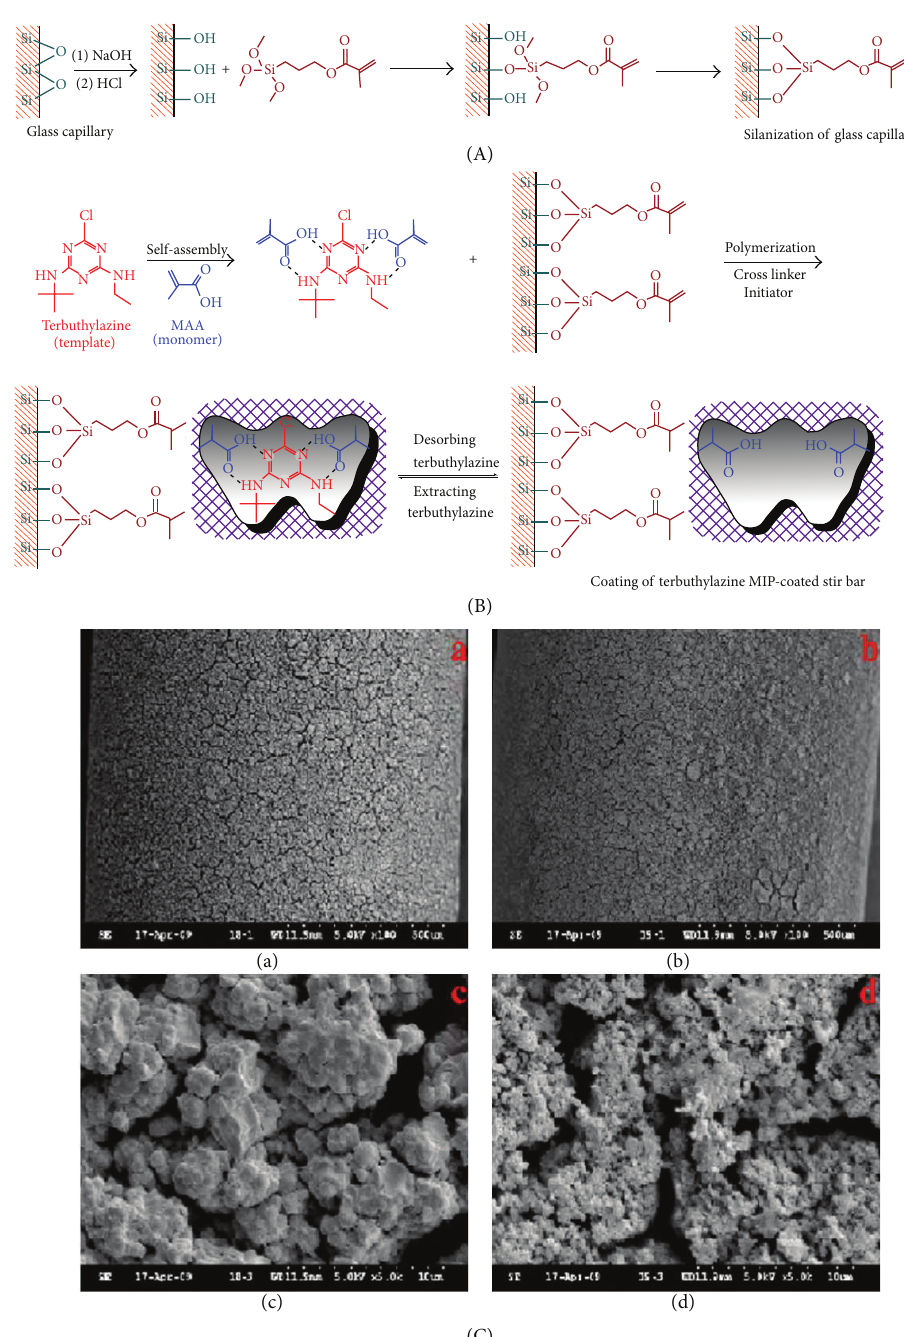
Figure 11: Schematic diagrams of the preparation of MIP-SBSE coating using terbuthylazine as template molecule and Scanning electron micrographs of the surface structure of the MIP- and NIP-coated stir-bar. (a) and (c) are the NIP coating for magnitude of 100 and 5000, respectively, (b) and (d) are the MIP coating for magnitude of 100 and 5000, respectively